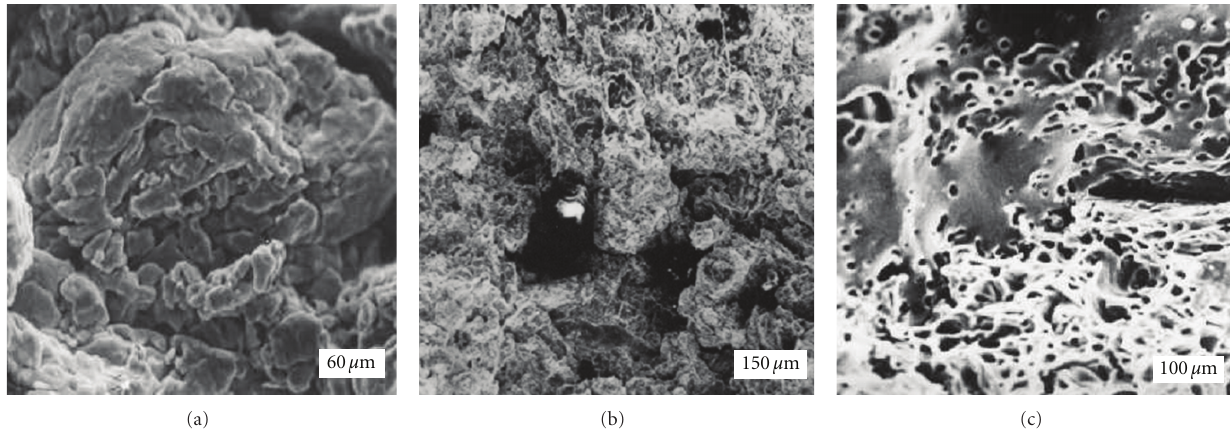
Figure 1: Fractography of the iron grade PZh4M2 specimens: (a) after pressing, × 500; (b) P = 18%, × 200; (c) P = 10%, × 700.